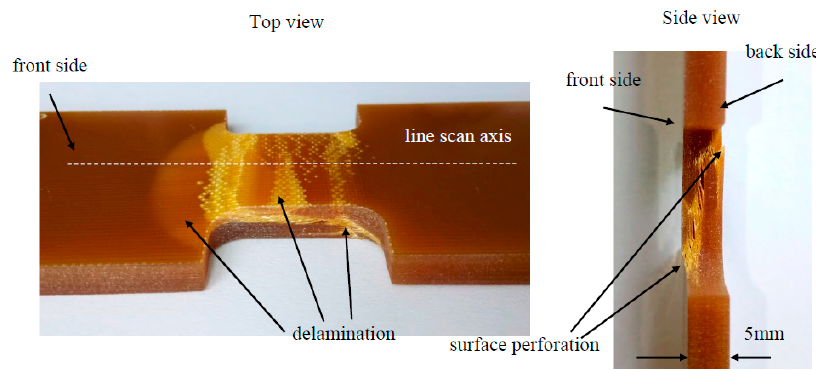
Figure 9. Photo of the multilayered polymer composite structure subjected to stress resulting in multiple delaminations.